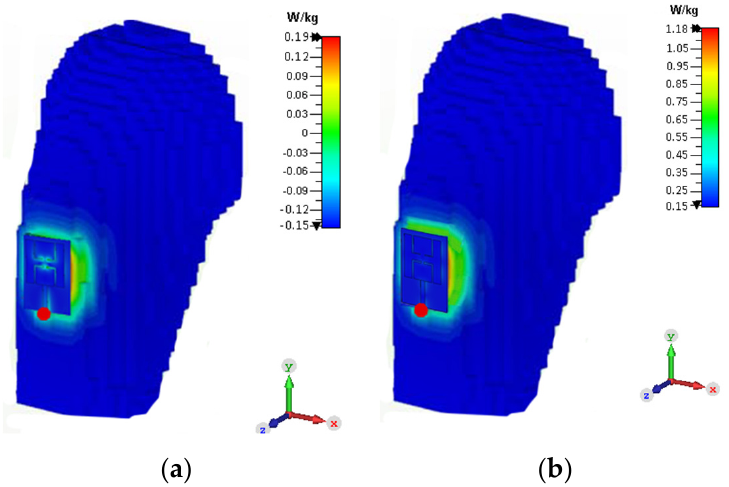
Figure 14. SAR distribution of the dual-band antenna; ( a ) at 2.45 GHz and ( b ) at 5.8 GHz.